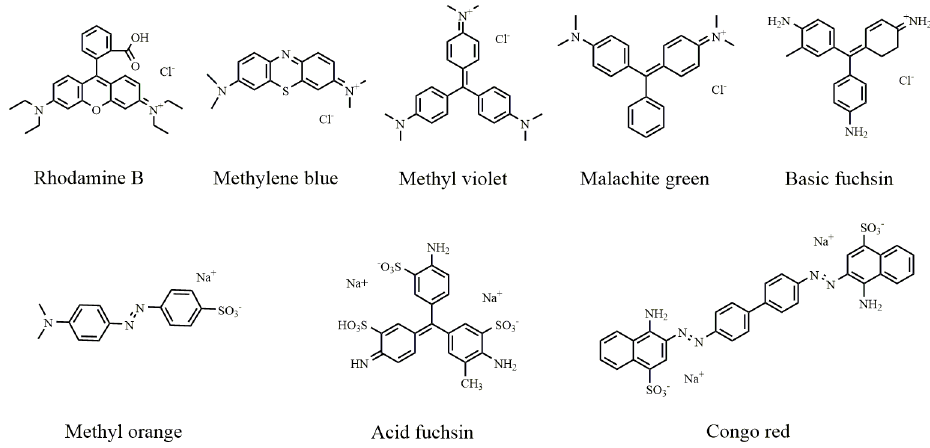
Figure 1. Chemical structure of cationic and anionic dyes mentioned in this study.